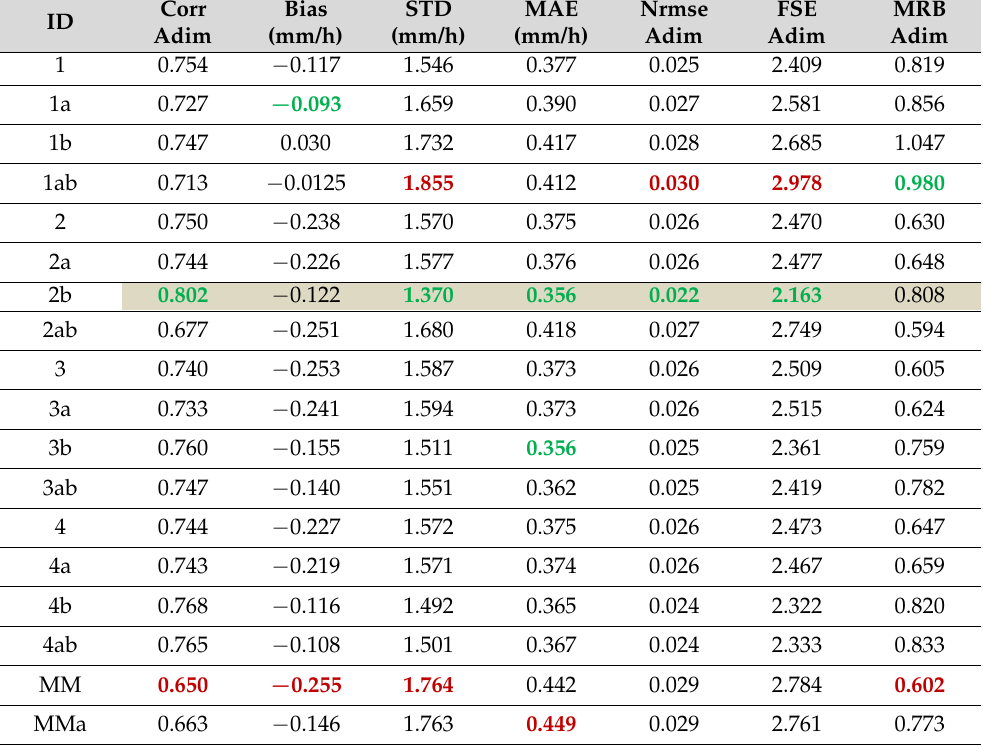
Table 5. Overall error indices of the merging methods, given in Table 3, tested in the composite domain using the whole dataset listed in Table 4 (note that MMa stands for MM anisotropic technique). The green and red numbers indicate the best and worst technique for each statistical index (column), whereas the grey row indicates the overall best performing technique (2b, AvgAni). Corr Bias ID Adim